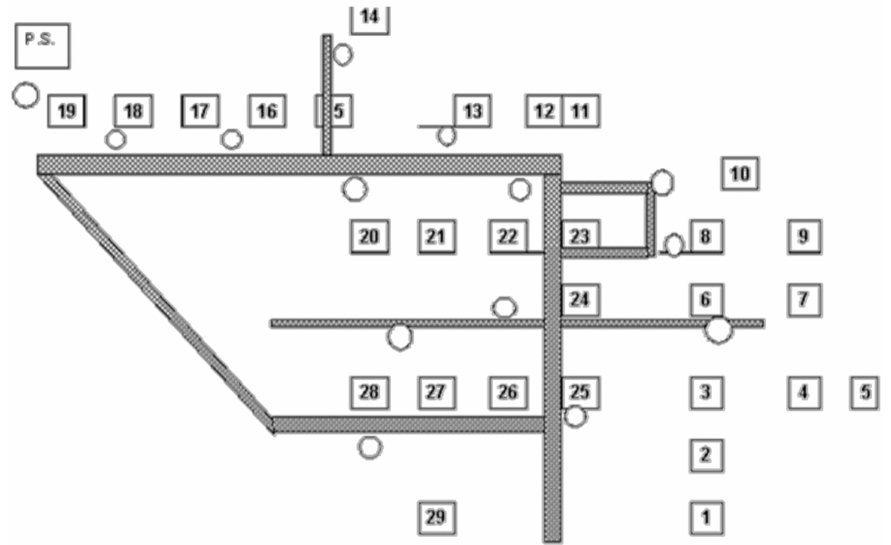
Figure 4. Map of Rajmachi village showing the customer load points (courtesy: Maharashtra Energy Development Agency